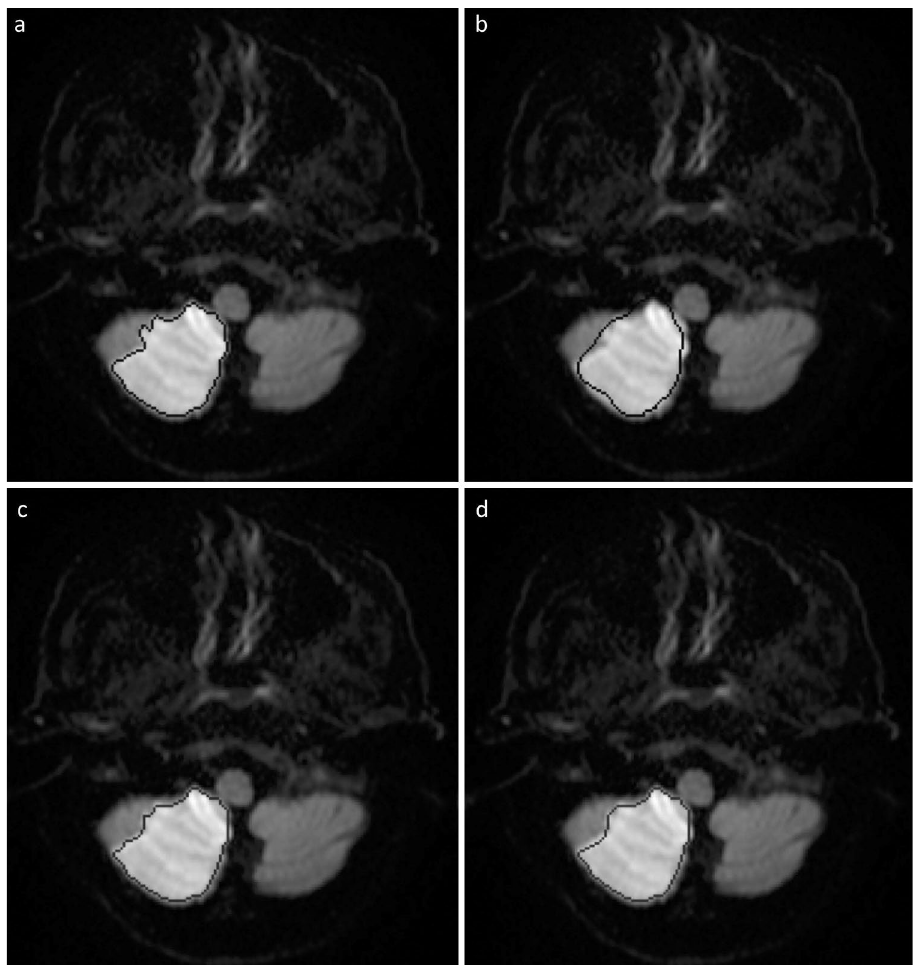
Figure 4. Acute ischemic lesion segmentation of model B on the external test. Figures shows images of a 64-year-old male patient with acute ischemic lesion in the right cerebellar hemisphere. (A) Ground-truth segmentation mask created by the neuroradiologist. (B) The segmentation of native model B. Note the incorrect contours, which is more profoundly marked in the lateral part of the lesion. (C) The segmentation by the radiologist. (D) The segmentation by fine-tuned model B. Note that the fine-tune model demonstrates similar segmentation performance to that of the radiologist, while delineating the borders of the lesion much correctly than the native